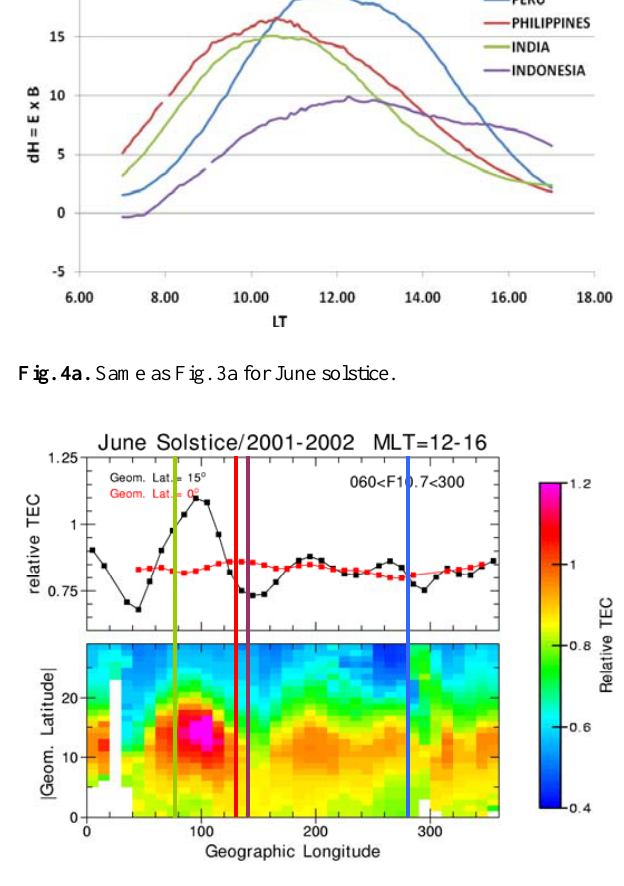
Fig. 4b. Same as Fig. 3b for June Solstice.